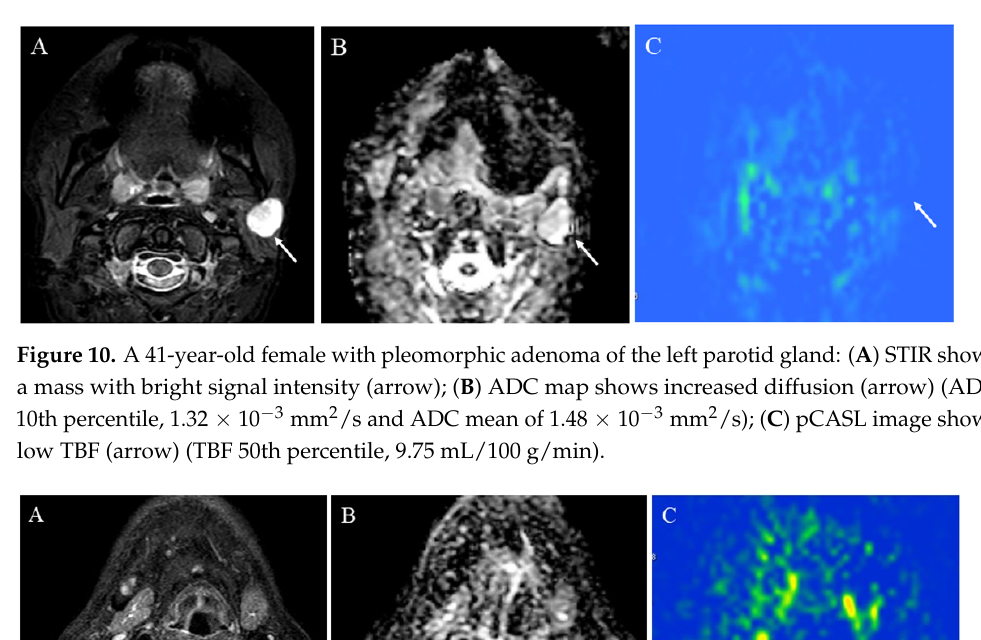
Figure 9. A 72-year-old male with acinic cell carcinoma of the right parotid gland: ( A ) STIR shows a mass with high signal intensity (arrow); ( B ) ADC map shows mild restricted diffusion (arrow) (ADC 10th percentile, 0.93 × 10 − 3 mm 2 /s and ADC mean of 1.03 × 10 − 3 mm 2 /s); ( C ) pCASL image shows high TBF (arrow) (TBF 50th percentile, 34.26 mL/100 g/min).